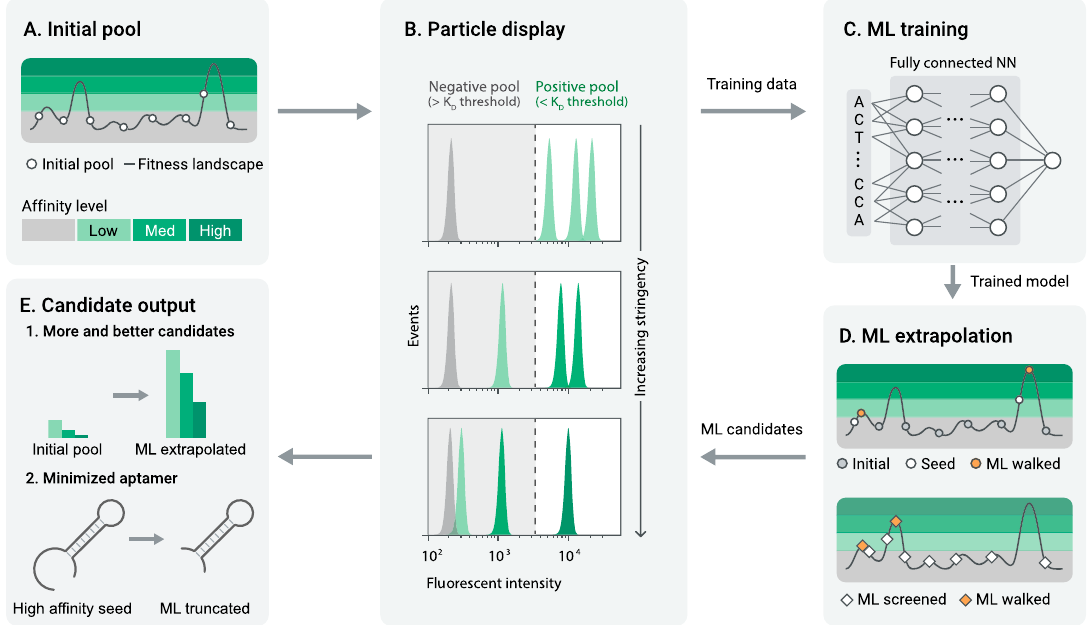
Fig. 1 MLPD overview. a Aptamer candidates from a physical pool (white dots) sample a small portion of the fi tness landscape (dark gray line), each with a corresponding af fi nity level (light to dark green). b Particle display discerns the af fi nity level of each candidate by interrogating the library at multiple stringency levels. c Aptamer sequences and their corresponding af fi nity levels are used to train and validate a neural network ML model. d The ML model extrapolates new sequences on the fi tness landscape in two ways: (1) mutating existing candidates (white dots) in a model-guided fashion (orange dots), and (2) nominating novel sequences in silico, predicting their position on the fi tness landscape (white diamonds) and walking top-performing sequences to higher af fi nity levels (orange diamonds). The extrapolated candidates are synthesized and experimentally tested. e MLPD yields more candidates at each af fi nity level compared to the initial library, and enables sequence truncation without reduction in af fi